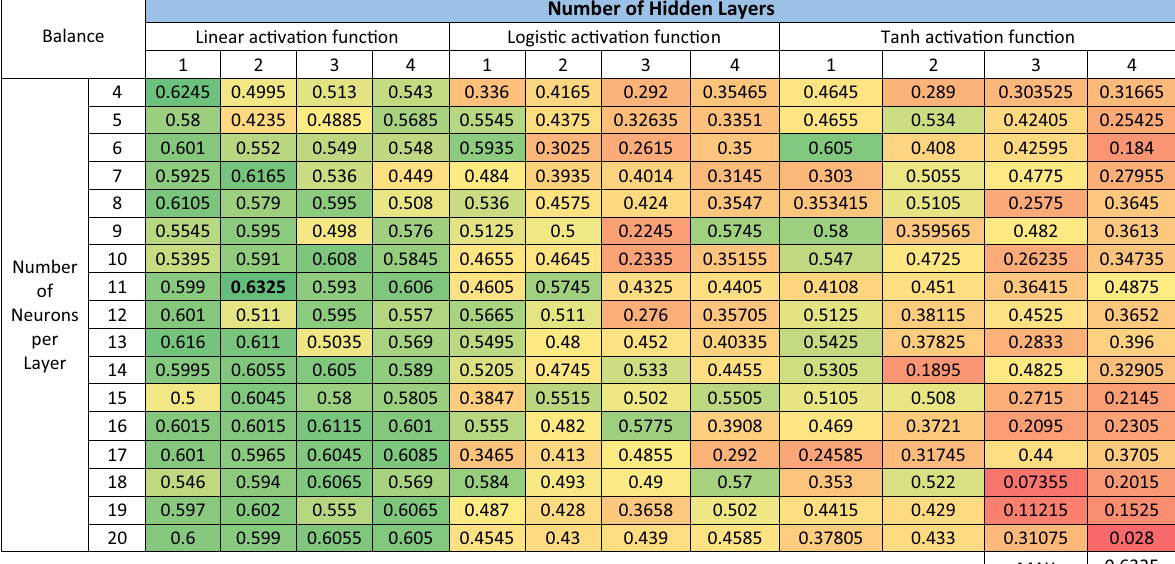
Number of Hidden Layers